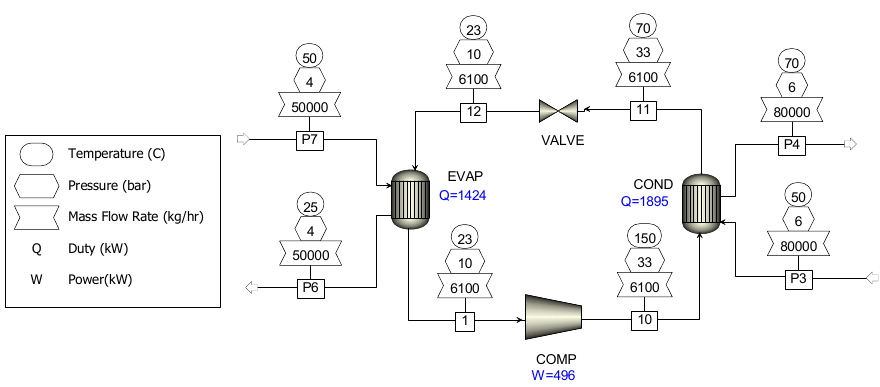
Figure 4. The scene of four series-connected high-temperature heat pumps with the results of computer simulation using the Aspen Plus software package.